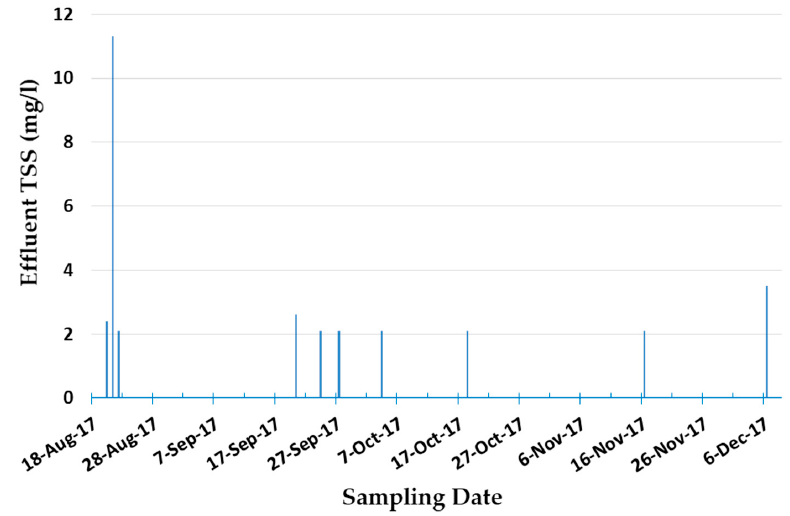
Figure 6. Effluent total suspended solids (TSS) results of samples collected from 20 August 2017 to 6 December 2017.